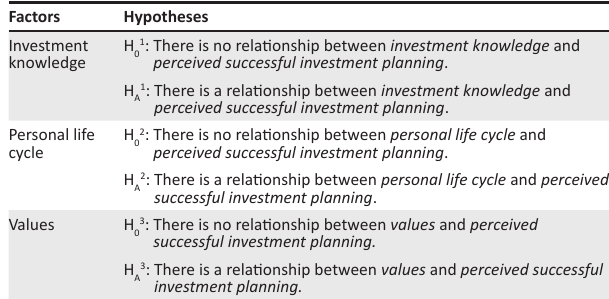
TABLE 3: Summary of revised hypotheses.